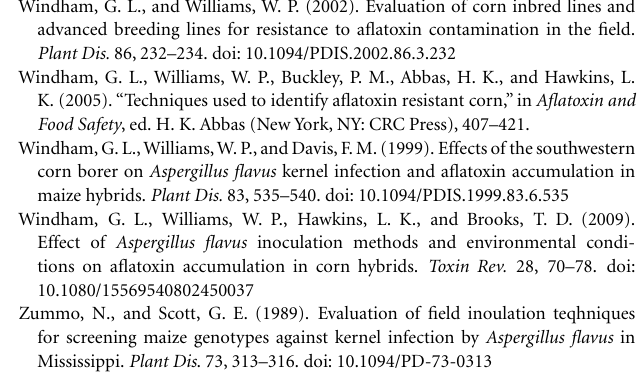
ConflictofInterestStatement: Theauthorsdeclarethattheresearchwasconducted in the absence of any commercial or financial relationships that could be construed as a potential conflict of